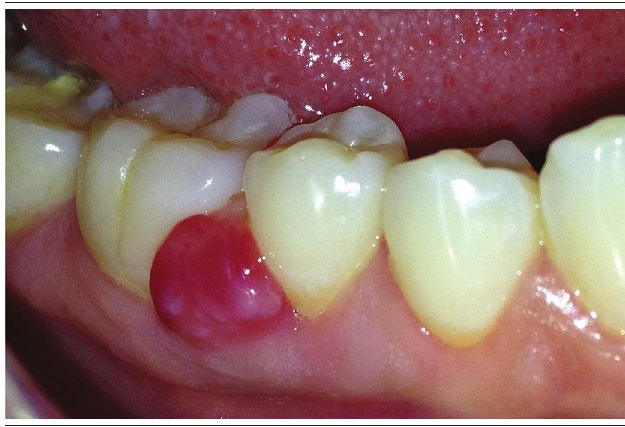
Figura 1 − Nódulo séssil e avermelhado na gengiva vestibular mandibular direita entre o segundo pré-molar e o primeiro